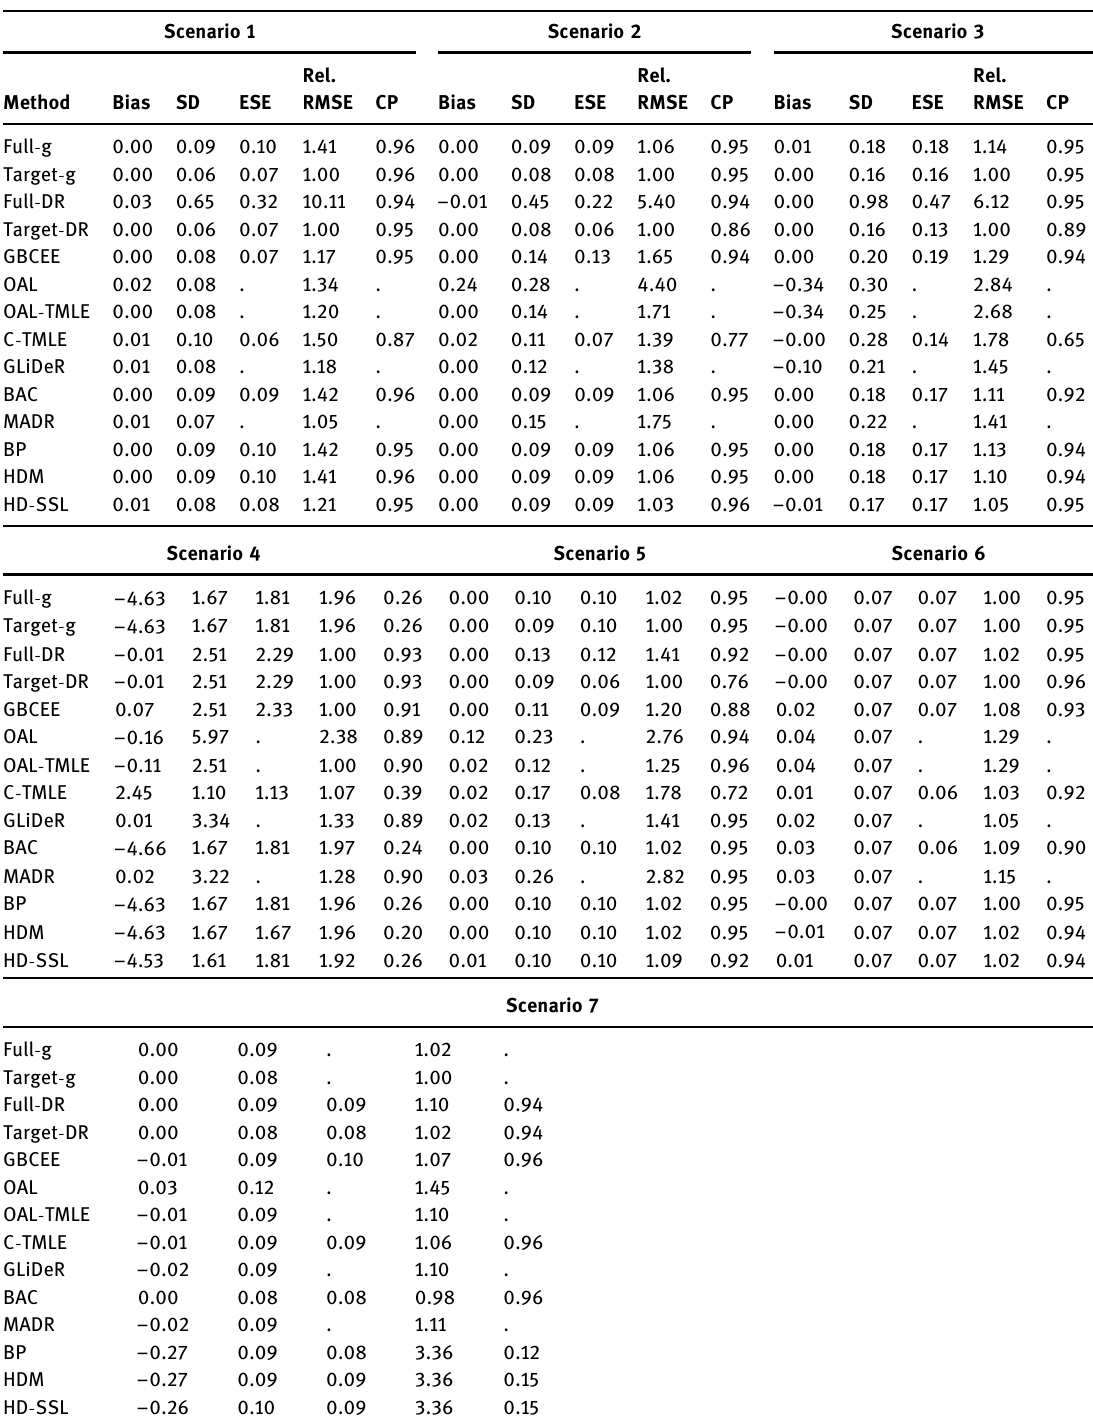
Table 2: Results of simulation Scenarios 1 – 7, with